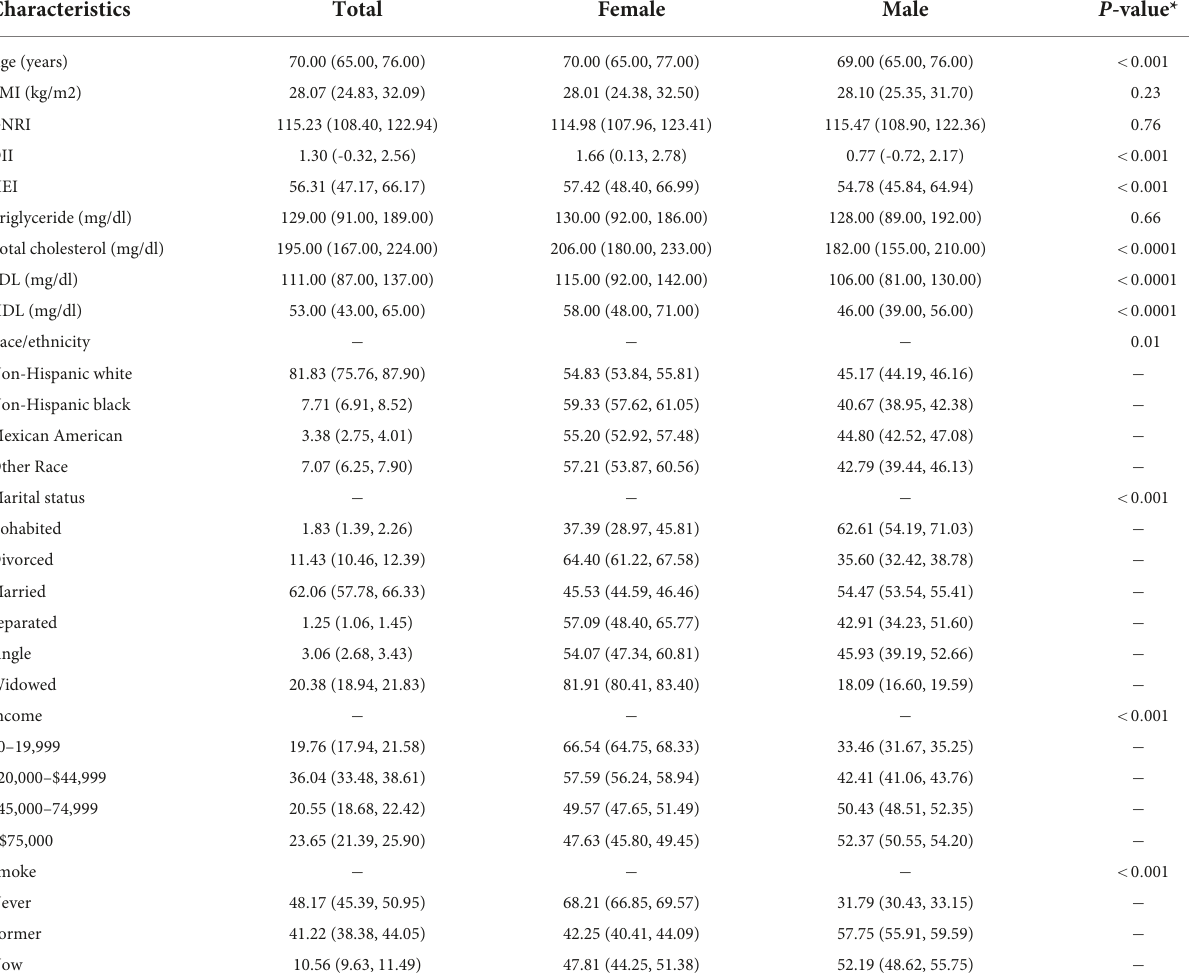
TABLE 1 Baseline demographic characteristics of all participants in this